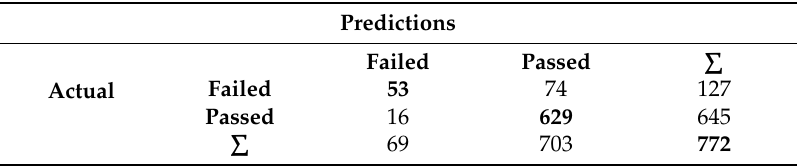
Table 12. Sample confusion